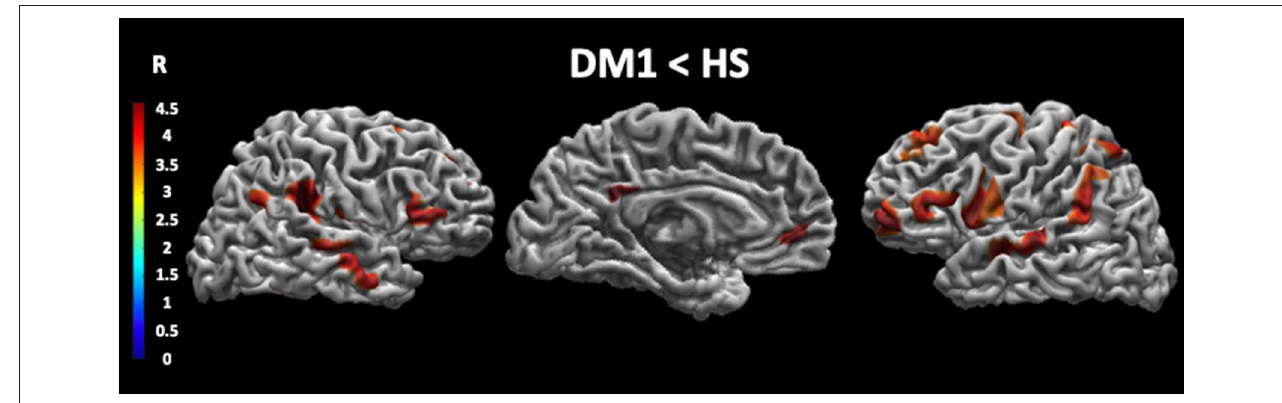
FIGURE 1 | Cortical thickness in DM1 patients compared with HS. This figure reveals that patients with DM1 compared to healthy subjects showed a significant decrease in cortical thickness in several brain areas. In particular, the cortical thickness is significantly decreased in the precuneus, the angular gyrus, the superior temporal gyrus and the medial frontal gyrus bilaterally, the right precentral gyrus, the right posterior and anterior cingulate cortex, and the left superior parietal lobule. The statistical comparisons were overlapped on MRIcron ch2bet template (https://www.nitrc.org/projects/mricron). DM1, myotonic dystrophy type 1; HS, healthy subjects; R, right.